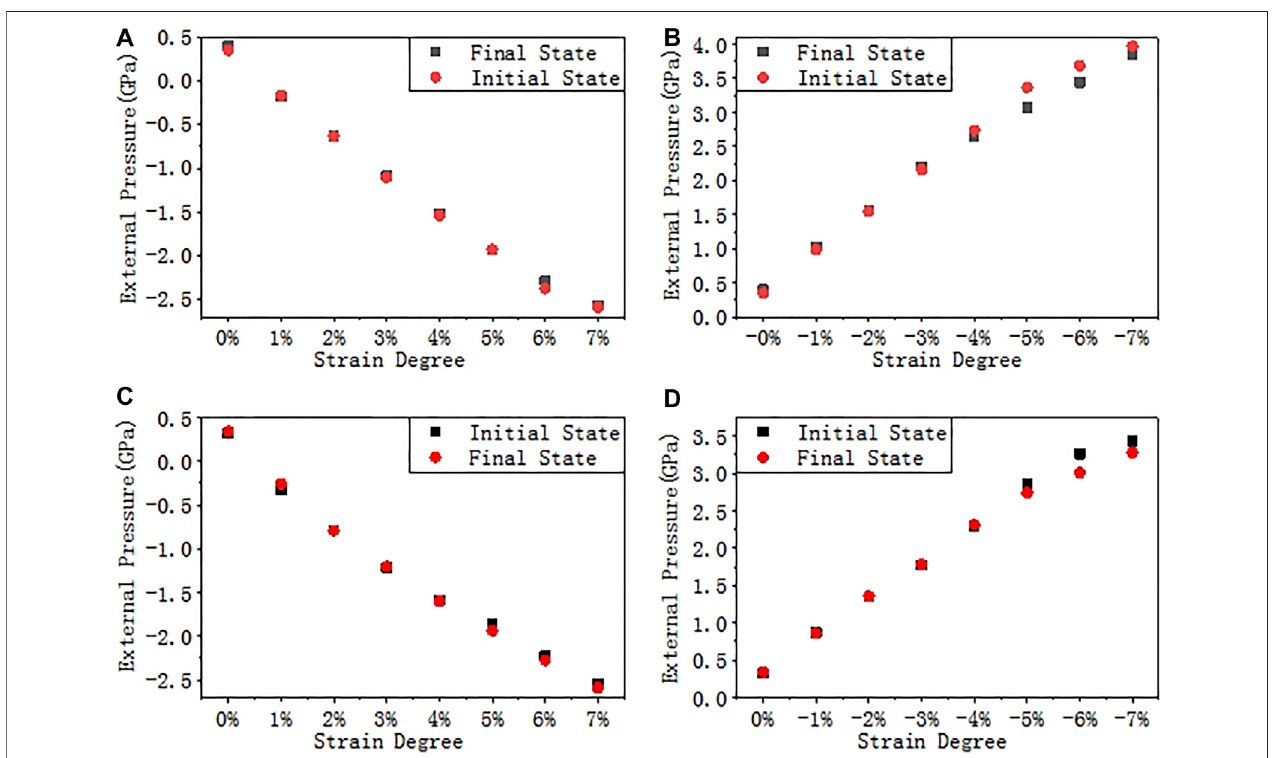
FIGURE 5 | Stress-strain curves. (A) Tensile strain on interface (111), (B) Compressive strain on interface (111), (C) Tensile strain on interface (100), and (D) Compressive strain on interface (100).